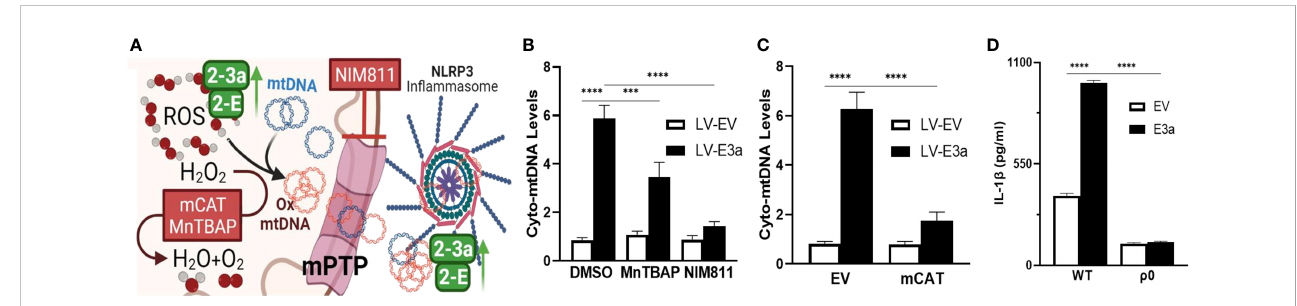
FIGURE 4 2-E+2-3a viroporins induced mROS is required for the release of mtDNA from the mitochondrion into the cytosol via the mtPTP. (A) Representative Figure. (B, C) 293T cells were transduced with LV-EV or LV-E3a. (B) 24 hrs post-transduction cells were treated with or without 50 uM MnTBAP or 10 m M NIM811. 10 hrs post-treatment, cells were lysed, cytosolic-enriched fractions collected, DNA isolated from the cytosolic-enriched fractions, and levels of cytosolic mtDNA determined by RT-PCR with a probe speci fi c for MT-ND5 . (C) 6 hrs post-transduction with LV-EV or LV-E3a, 293T cells were transfected with p-mCAT or its control plasmid p-EV. 24 hrs post-transfection, levels of cytosolic mtDNA were determined as described above. (D) 293T or 293T- r 0 cells transduced with LV-EV or LV-E3a were transfected with the NLRP3-I plasmids the supernatants analyzed for IL-1 b by ELISA. Error bars represent SEM from 3 independent experiments; statistically signi fi cant data is indicated with asterisks (*).